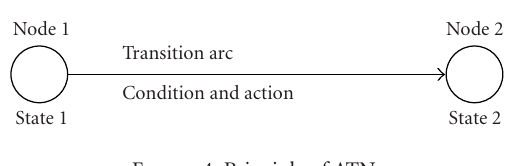
Figure 4: Principle of